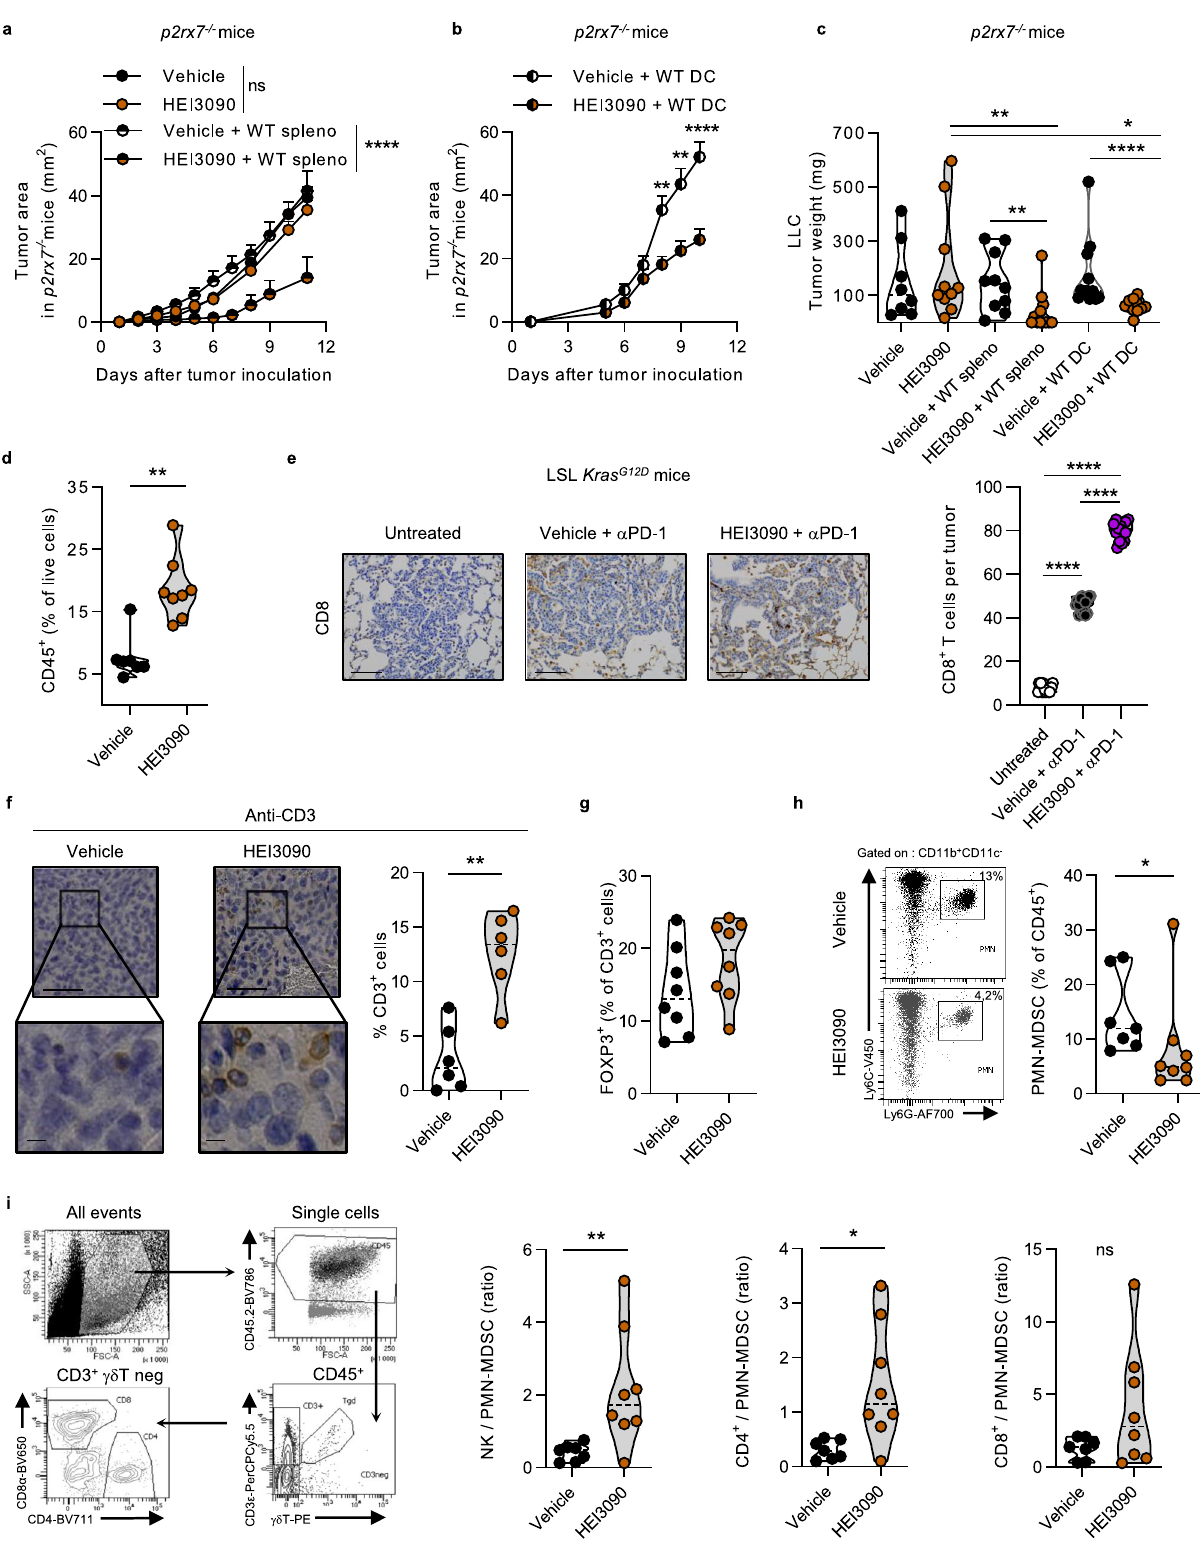
that HEI3090 retained its antitumor activity in mice treated with IL-1 β neutralizing antibody, HEI3090 did not modify IL-1 β protein levels in serum (Fig. 4d) and did not modulate IL-1 β secretion in macrophages cultured ex vivo (Supplementary Fig. 9c, d).